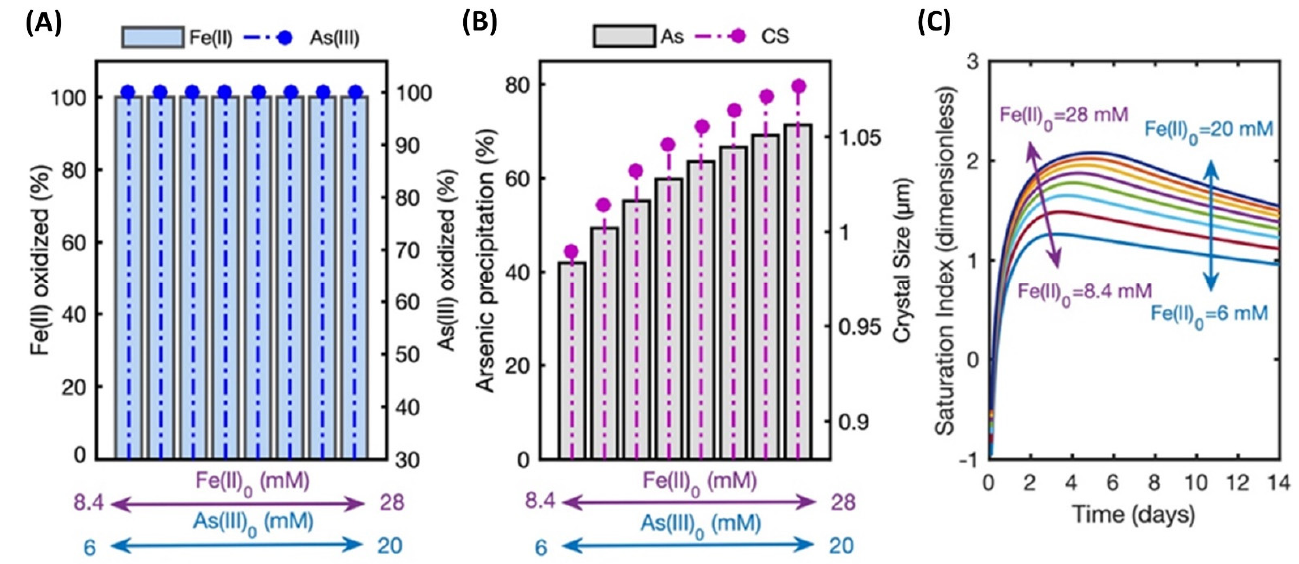
Figure 5. Effect of initial Fe(II) and As(III) concentrations on the scorodite crystallization process, maintaining an initial Fe(II)/As(III) molar ratio of 1.4 ( A – C ).